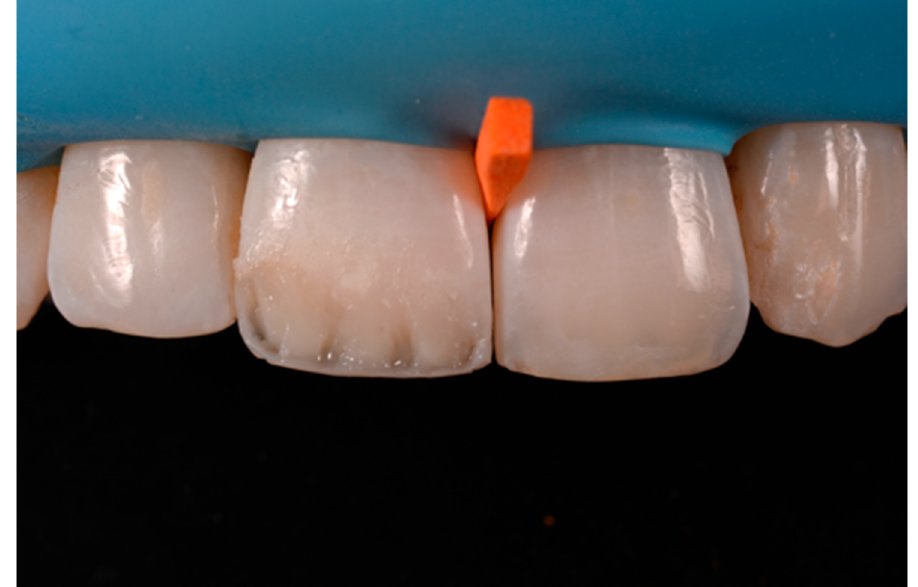
Figure 54. Dentinal body.